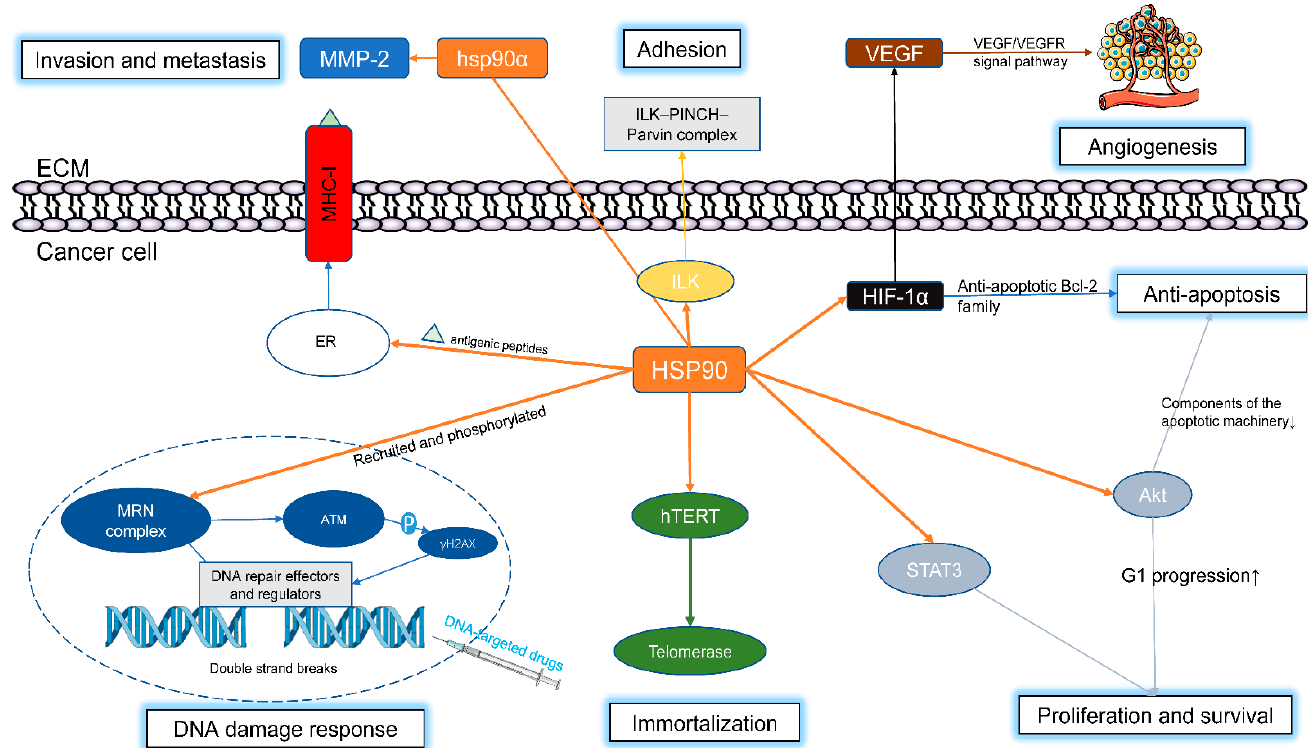
Figure 2. HSP90 in tumor progression. Many HSP90 client proteins are involved in numerous pro- cesses related to tumor progression. Hsp90 interacts with hTERT promoter, increases level of telomerase and promote immortalization of cancer cells; HSP90 α is secreted into ECM and activate precursor of MMP which causes the decomposition of extracellular matrix; HSP90 client ILK recruits other components of ILK-PINCH-Parvin complex which is related to tumor’s adhesion; HIF-1 α is closely related to HSP90. HIF-1 α can affect expression level of VEGF which promote angiogenesis through VRGF/VEGFR pathway; HIF-1 α enhances the antiapoptotic effect of cancer cells by the antiapoptotic BCL-2 family; HSP90 is recruited by the MRN complex to DNA damage site and phos- phorylated by MRN. HEP90 assist MRN to activate ATM and initiate a series pathways of DNA damage repair; HSP90 client Akt can promote antiapoptotic effect of cancer cells by downregulating components of the apoptotic machinery. Akt promote tumor growth by accelerating G1 progression. HSP90 escorts the antigenic peptides to the ER and the antigenic peptides are loaded onto the newly synthesized MHC-I molecules. The MHC-I molecules carrying antigenic peptides are transported to the surface of cancer cell.